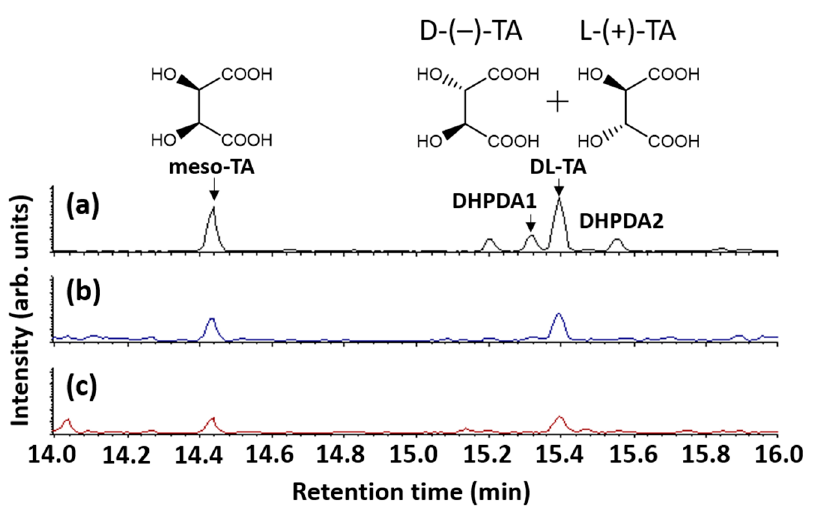
Figure 2. Mass-selected chromatograms of ( a ) m/z 292, ( b ) m/z 219, and ( c ) m/z 189 observed for SOA formed from toluene (run 10). The chemical structure of meso -, D-( − )-, and L-(+)-tartaric acid (TA) are shown together with the chromatograms. The peak of meso -TA, DL-TA, DHPDA1, and DHPDA2 appear in chromatogram of m/z 292.